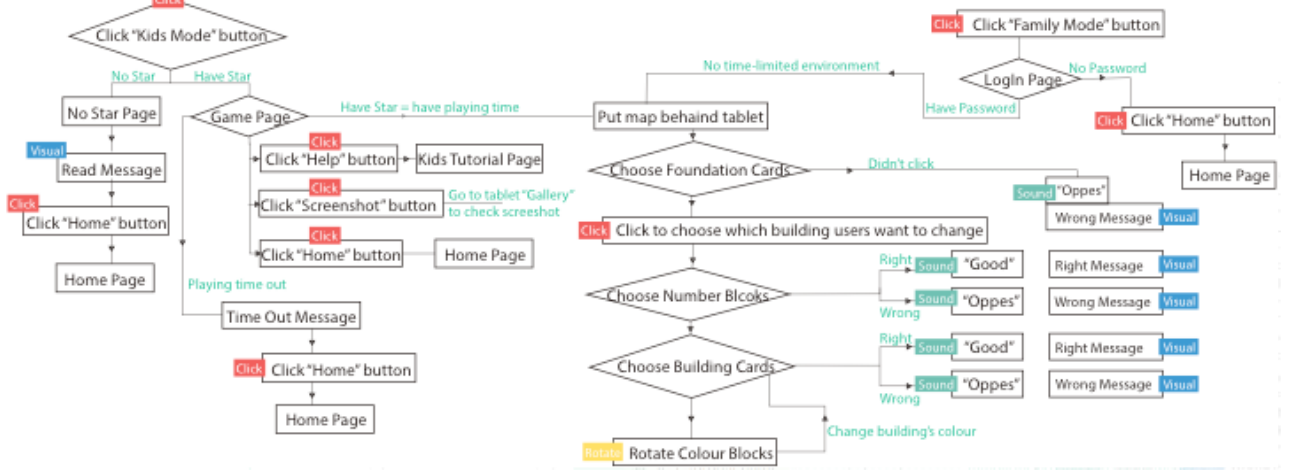
Figure 1 . System architecture of Kids’ Mode and Family